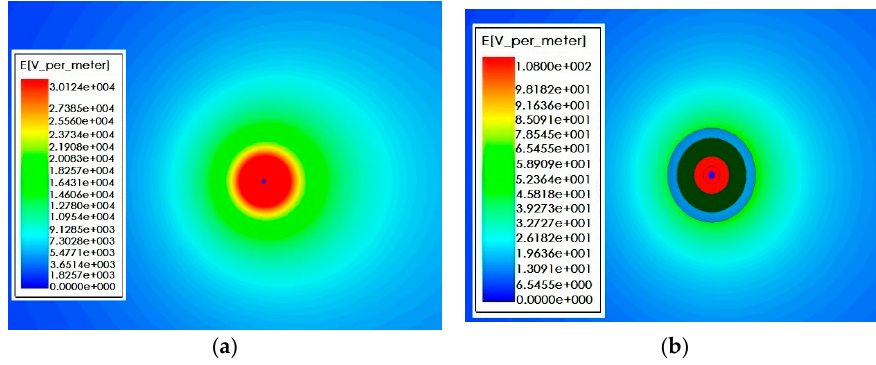
Figure 17. Influence of sensor on electric field. ( a ) A-phase electric field distribution without sensor; and ( b ) A-phase electric field distribution after introducing sensor.